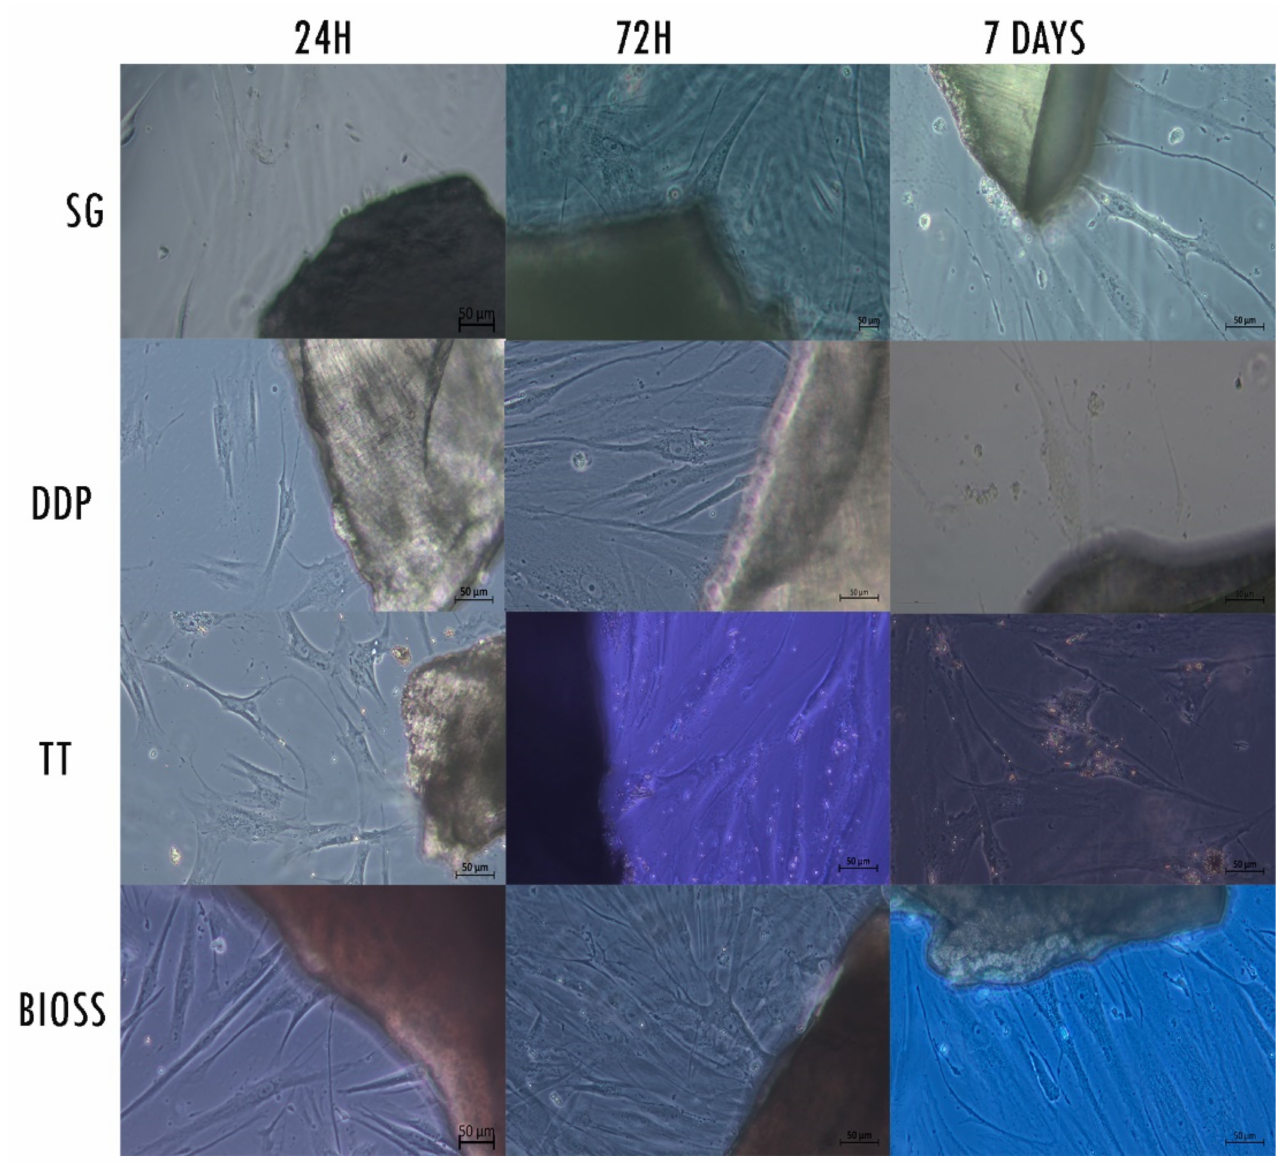
Figure 2. Contrast-phase light microscopy images of hPLF cells with the examined materials and the negative control at the different examined times. Magnification 20 ×